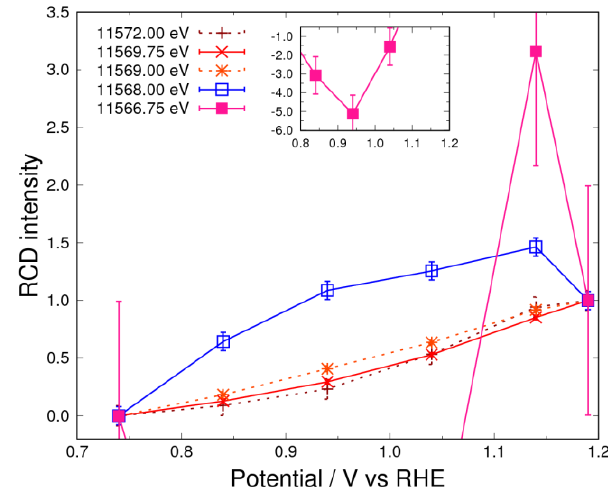
Figure 7. RCD curves for the controlled potential above 0.74 V in 1 M of KOH saturated with N 2 . The standard potentials are 0.74 V and 1.19 V. The filled and open square curves represent the negative and positive peak of 11,566.75 eV and 11,568.00 eV, respectively. The dashed lines complement the explanation for RCD.